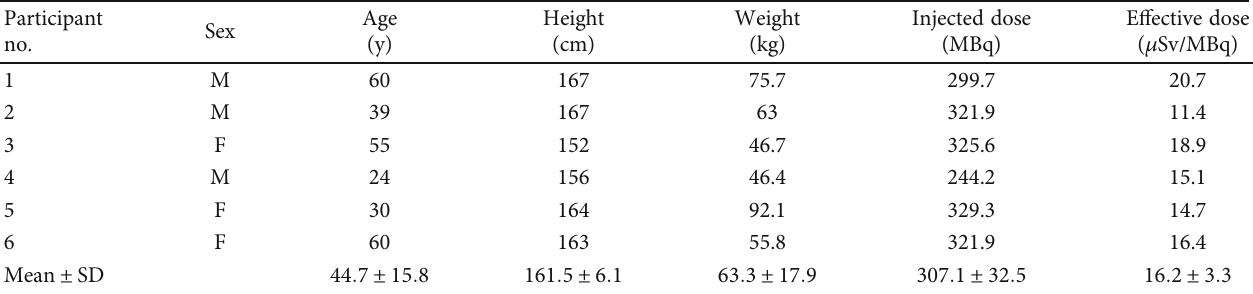
Table 1: Patients ’ demographic data.